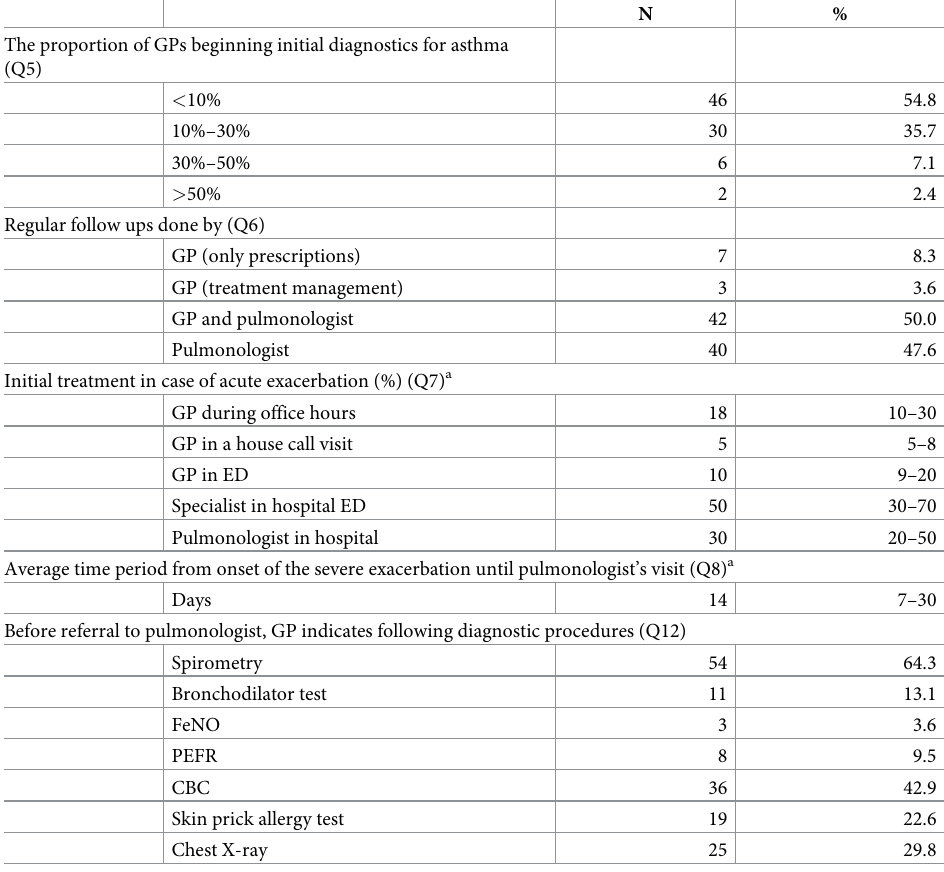
a Data are presented as frequency and percentage or as median and interquartile range